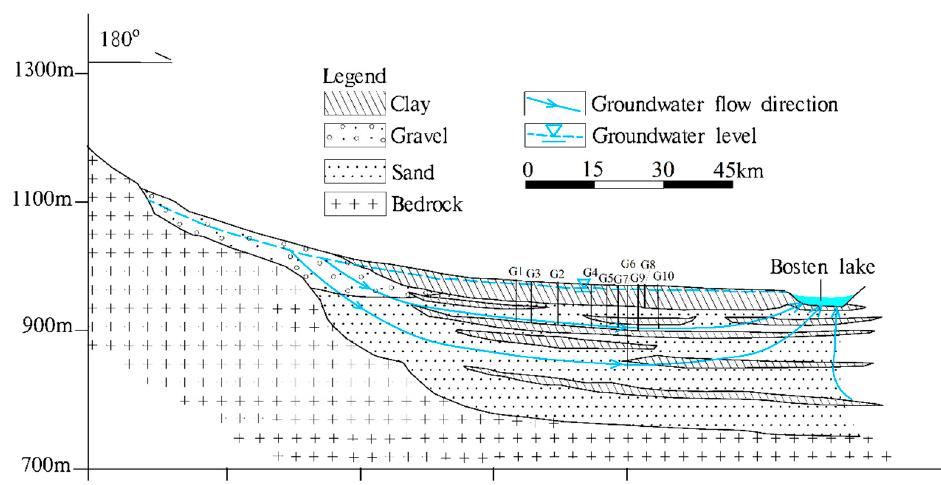
Figure 2. Hydrogeological profile of the study area. The X-axis is the horizontal distant from mountains to the Bosten lake and the Y-axis is the altitude